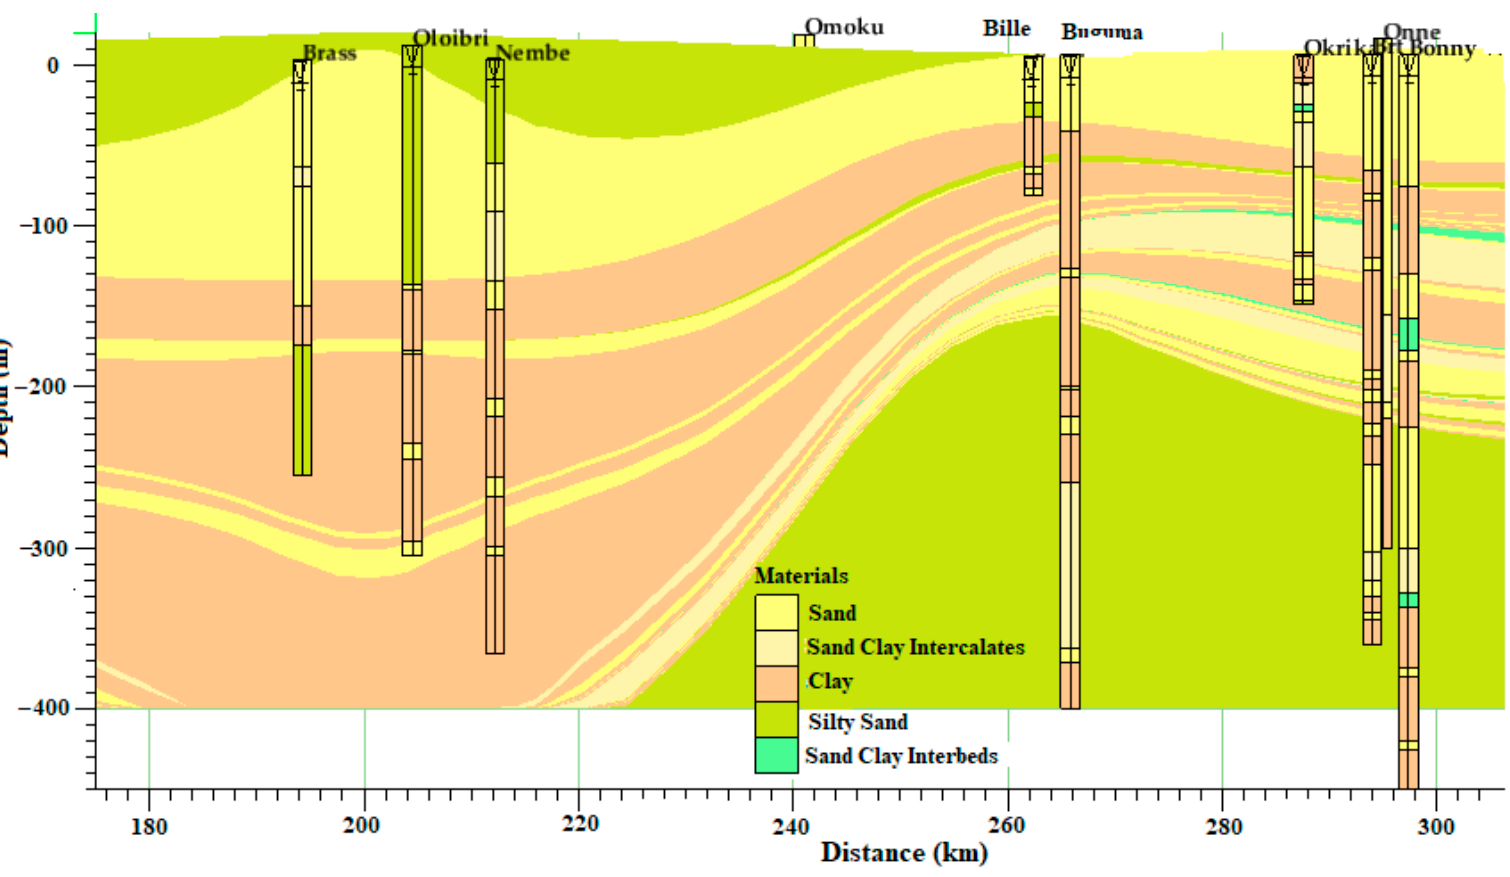
Figure 4. Hydrostratigraphic section along profile line BB I at various zones within the Niger Delta basin.